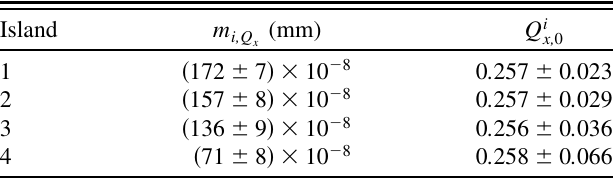
TABLE III. Linear relationships between fractional tune and total beam intensity ( N total in units of 10 10 protons ) as derived from the experimental and numerical data reported in Tables I and